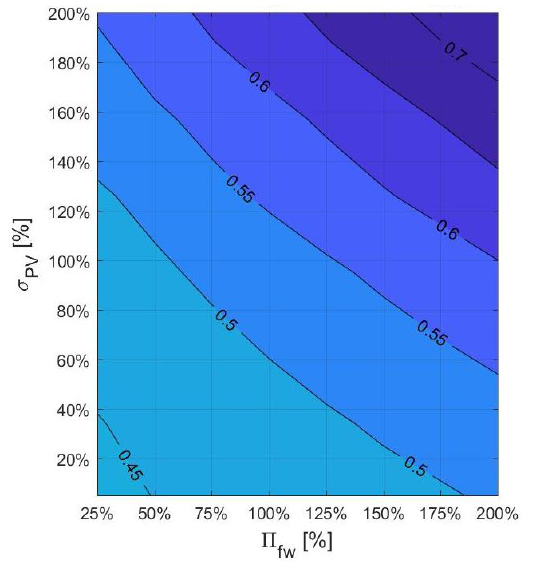
Figure 11. A preliminary study on the variation of LCOE (€/kWh). Iso-cost plots are drawn against the PV surplus factor σ PV and the flywheel power ratio Π FW.